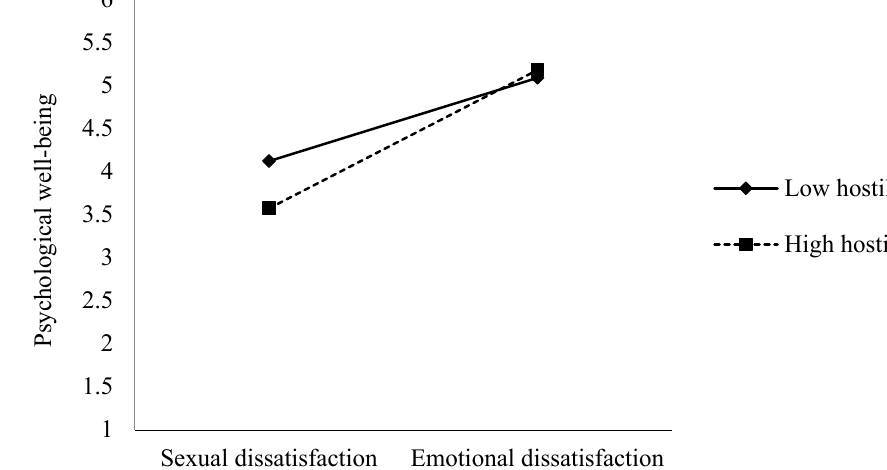
Figure 1. Interaction between motivations for infidelity and hostility on psychological well-being. There were no simple effects of infidelity motivations ( b = − 0.054, t = − 1.03, 95% CI [ − 0.206, 0.064], ∆ f 2 = 0.226) and negative affect on psychological well-being ( b = − 0.011, t = − 0.198, 95% CI [ − 0.096, 0.078], ∆ f 2 = 0.226), or interaction effects between negative affect and infidelity motivations on psychological well-being ( b = 0.002, t = 0.009, 95% CI [ − 0.160, 0.162], ∆ f 2 = 0.012).